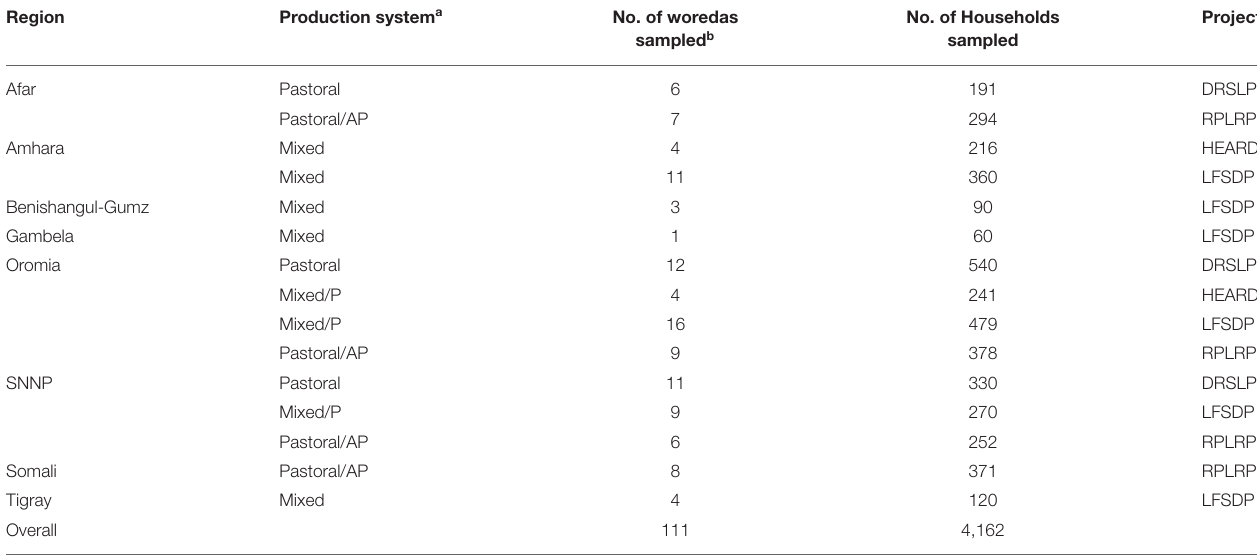
TABLE 1 | Source of data and data structure.